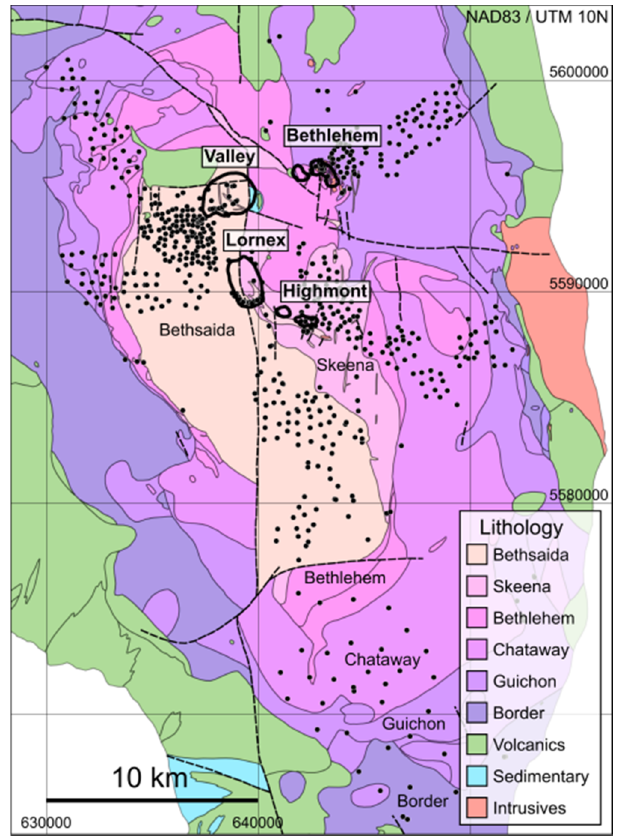
Figure 1. Regional lithological map of the Guichon Creek batholith, with labelled lithofacies. The locations of the major porphyry centers are indicated, and black outlines indicate open pits. The dots represent the locations of 755 rock samples used in this study. Modified after [24].